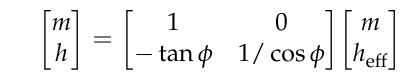
differential susceptibilities for model 2 were lower than for model 1 in both cases.